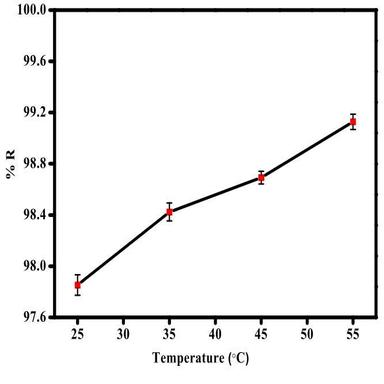
Effect of temperature.